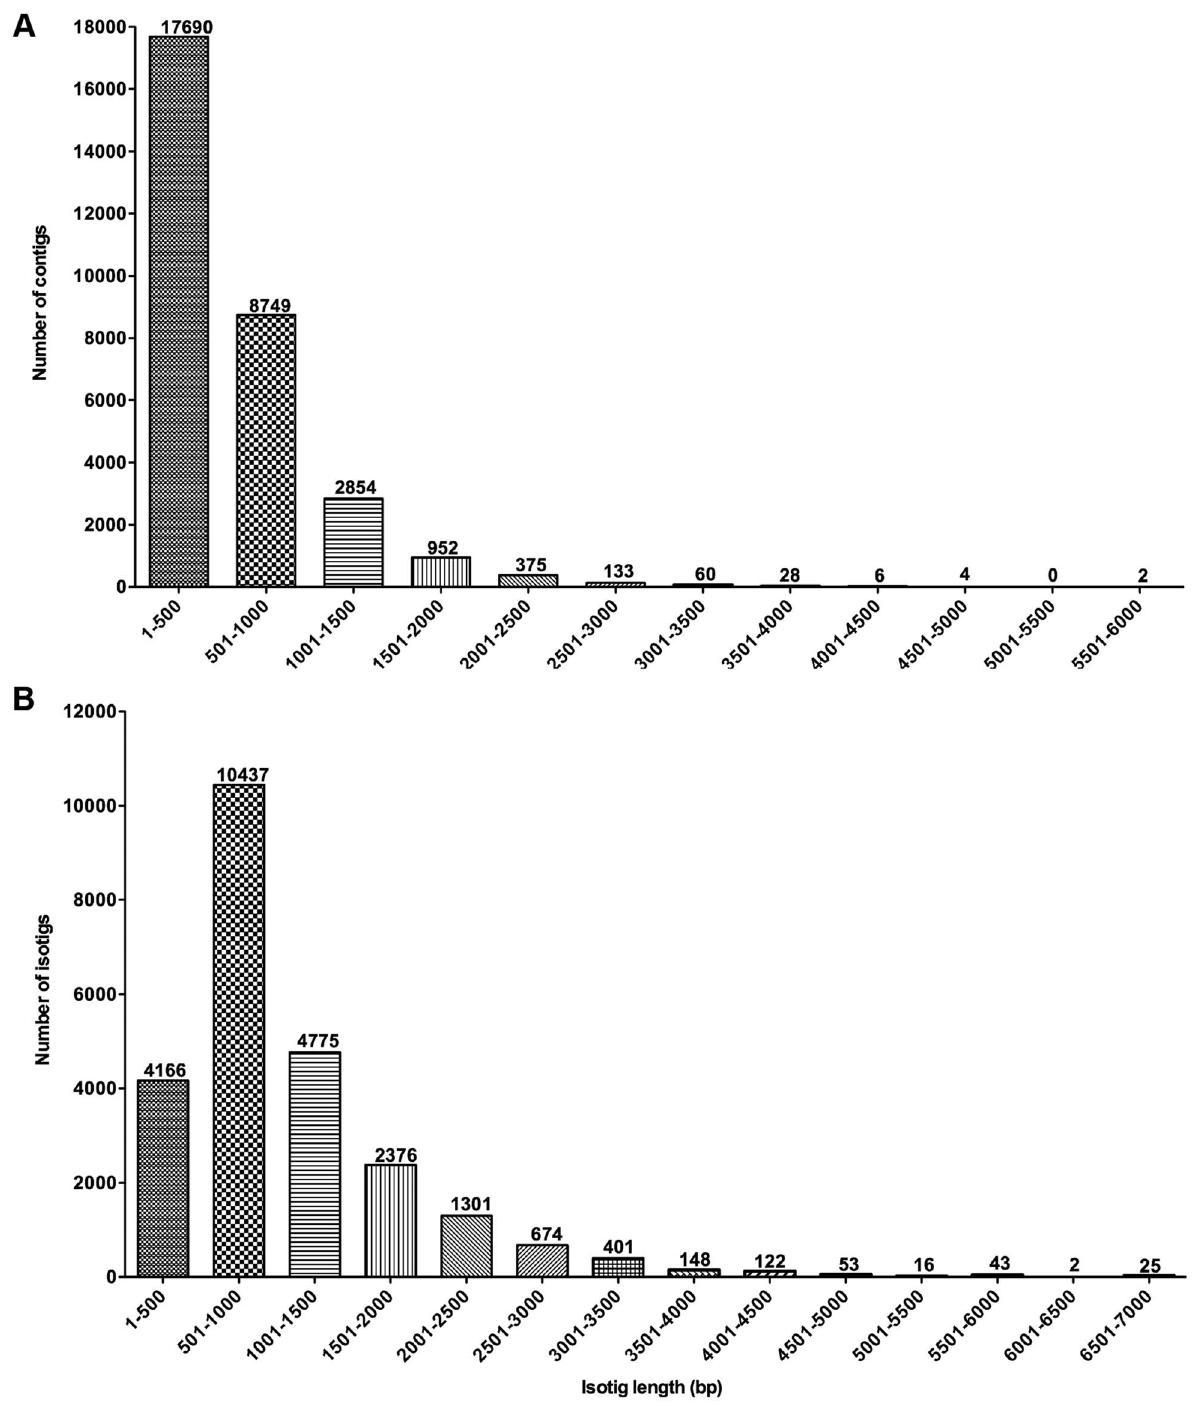
Figure 1. Size description of transcripts generated by denovo assembly of the quality filtered and trimmed 454 pyrosequencing reads using GS denovo assembler version 2.5.3 from B.henselae -infected and non-infected I.ricinus female salivary glands: A) contigs, B) isotigs.